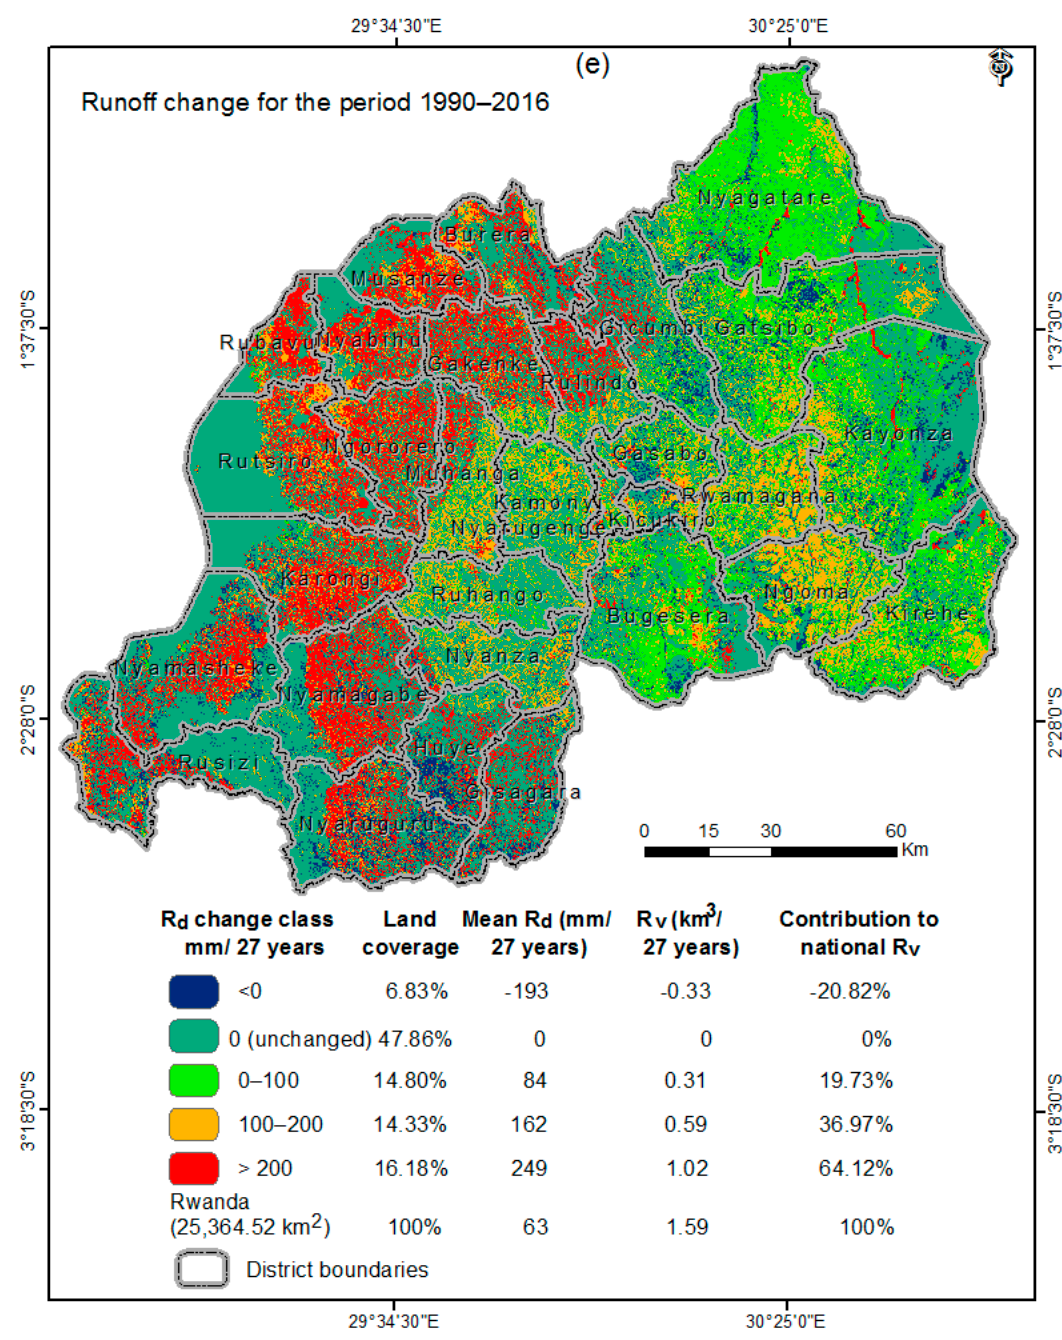
Figure 10. Spatial patterns of runoff depth (Rd) and runoff volumes (Rv) in ( a ) 1990; ( b ) 2000; ( c ) 2010; ( d ) 2016; and ( e ) the runoff changes from 1990 to 2016 in Rwanda, as estimated by the LUC ‐ ONLY scenario.